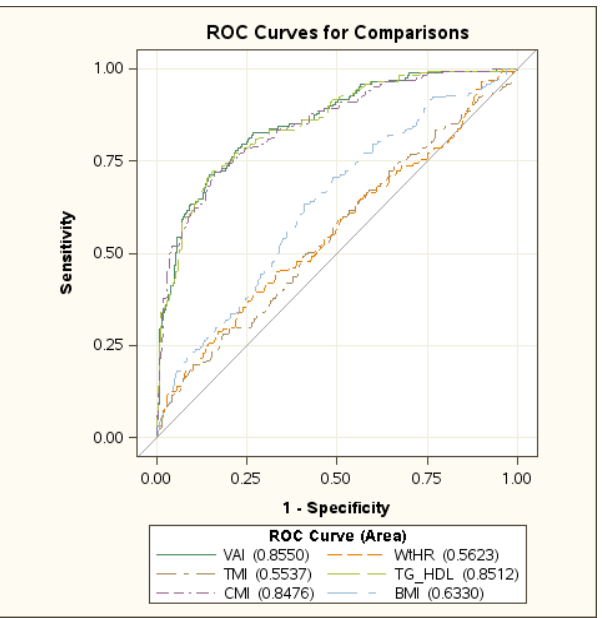
Figure 1. ROC curve in boys. Abbreviations: VAI: Visceral Adiposity Index; WtHR: Waist-to-Height ratio; TMI: Tri-Ponderal Mass Index; TG/HDL: triglyceride to high density-lipoprotein cholesterol ratio; CMI: Cardiometabolic Index; BMI: Body Mass Index.